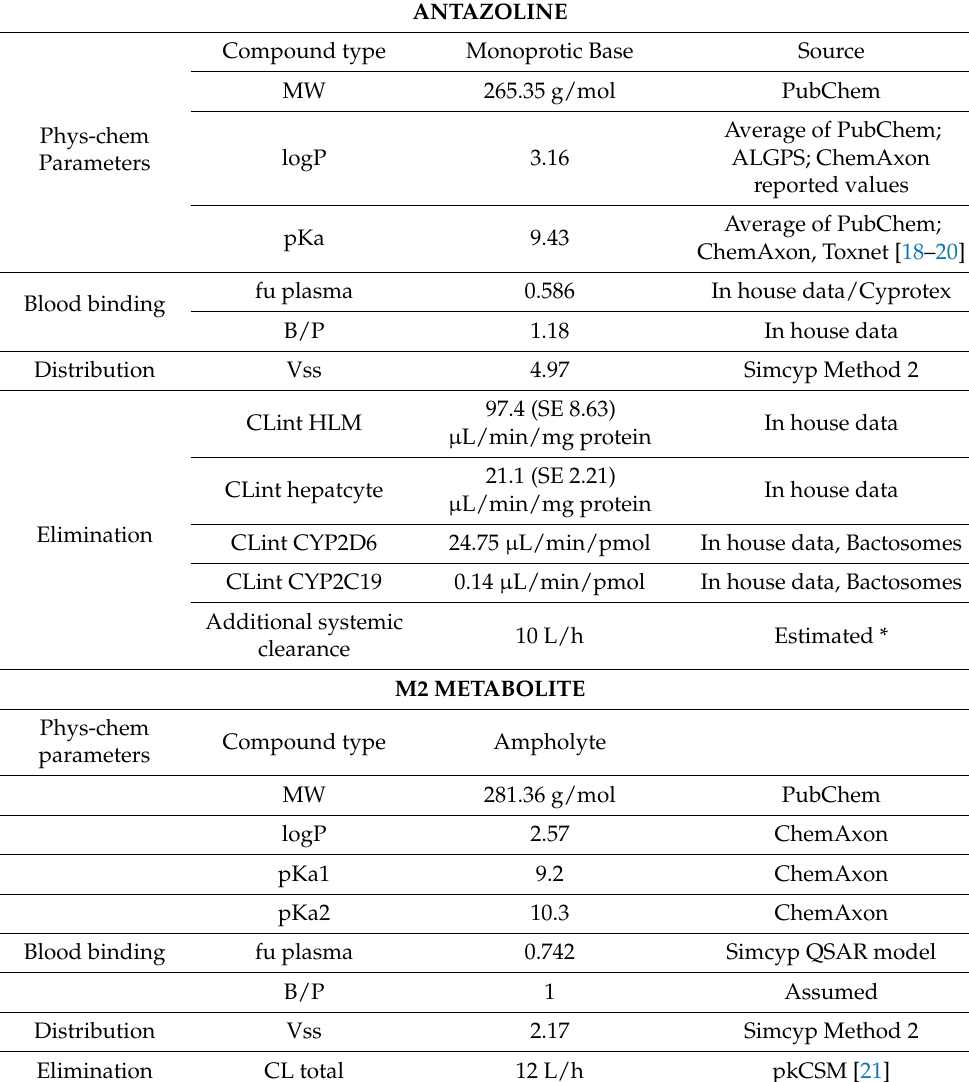
Table 3. Simcyp input parameters for final antazoline PBPK